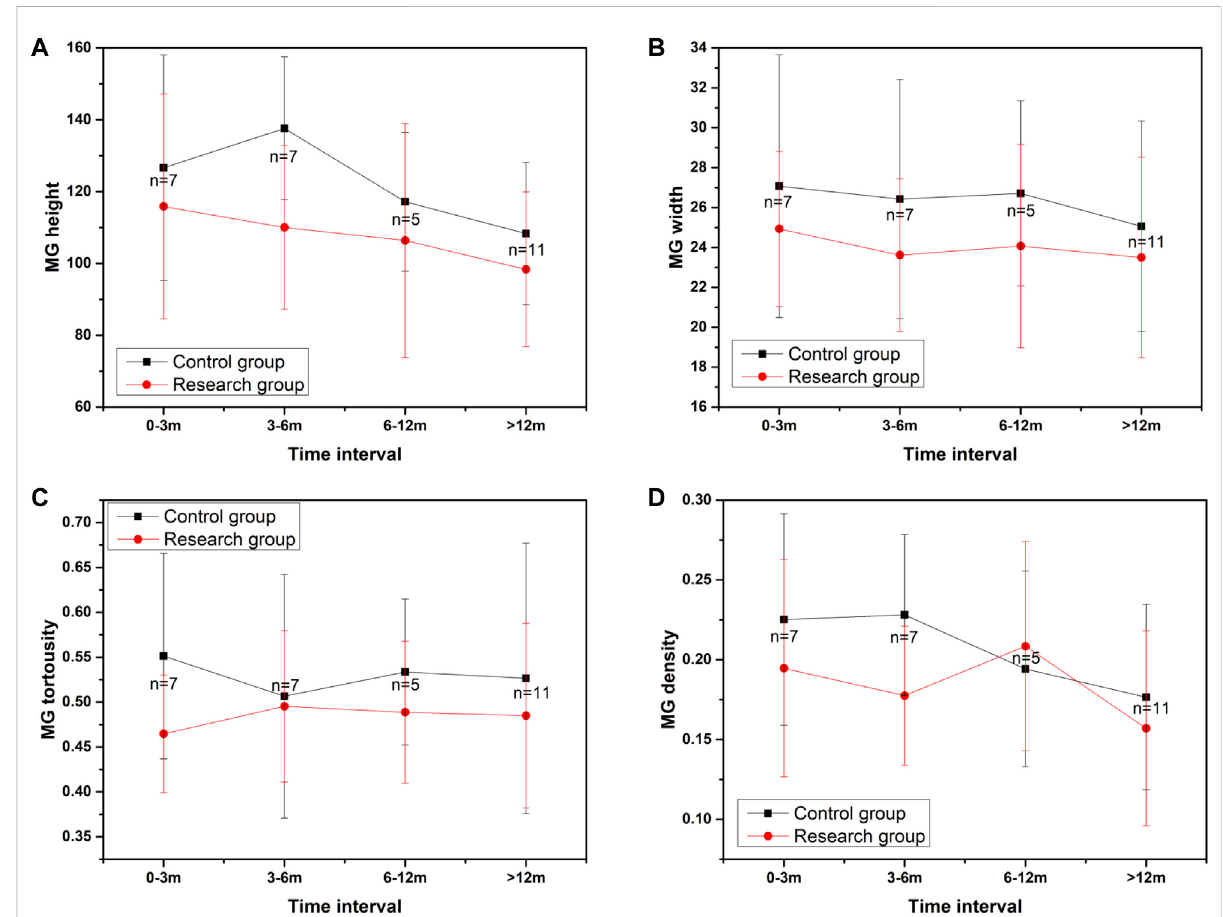
FIGURE 5 The changes in MG morphology parameters over time. (A) showed the changes in the average height of all MGs during follow-up visits, (B) showed the changes in the average width of all MGs during follow-up visits, (C) showed the changes in the average tortuosity of all MGs during follow-up visits, (D) showed the changes of MG density during follow-up